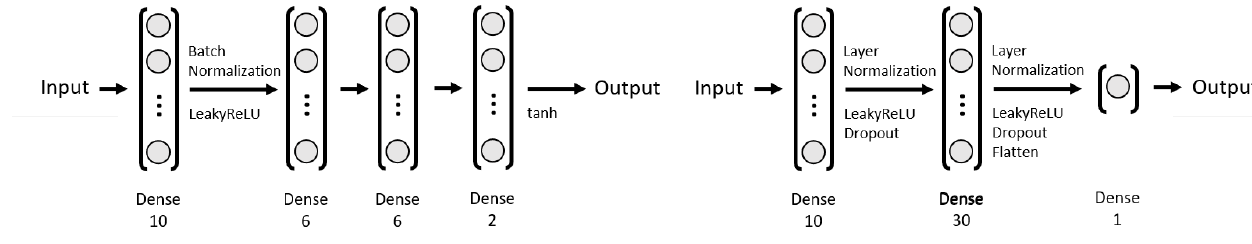
Figure 3. The structure of the generator ( left ) and critic ( right ) for the sinusoidal datasets.